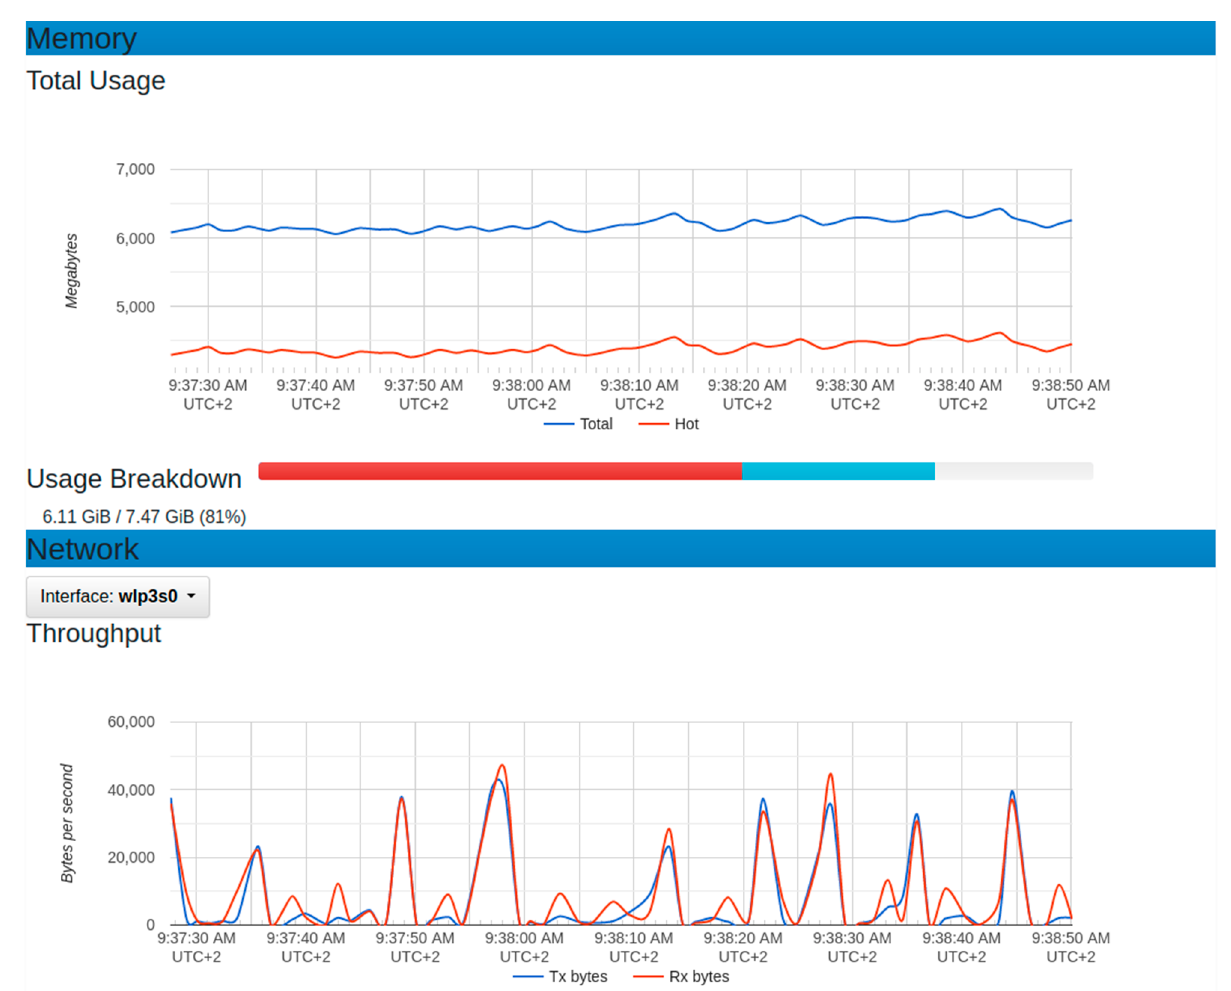
Figure 14. Resource usage for memory and throughput with normal sensor node setup.